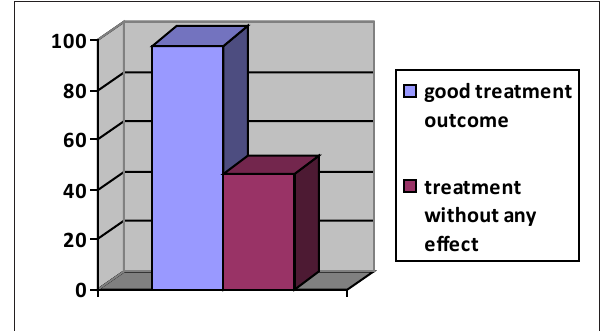
Fig. 1. Good treatment outcome (in total).